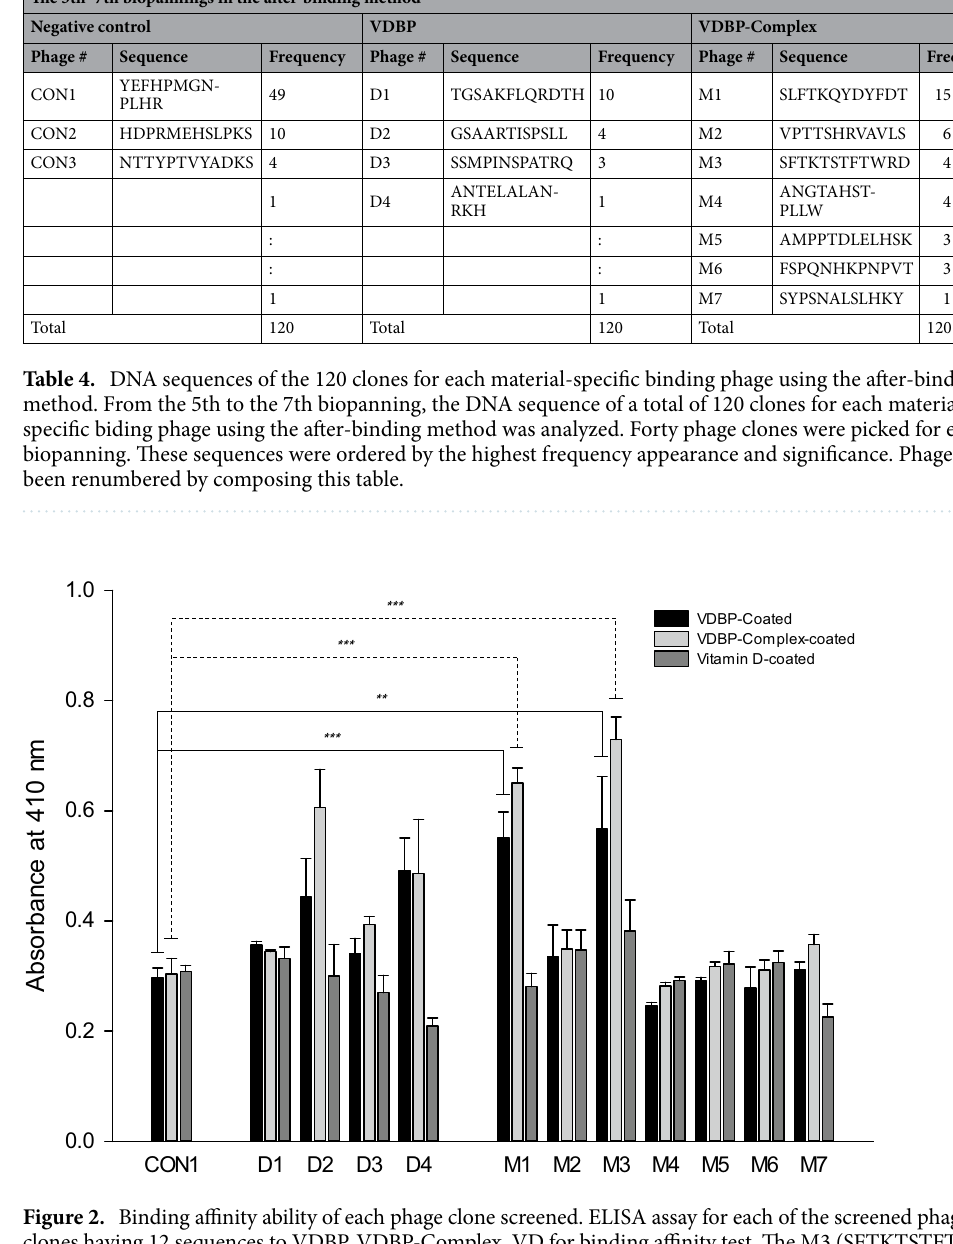
Figure 2. Binding affinity ability of each phage clone screened. ELISA assay for each of the screened phage clones having 12 sequences to VDBP, VDBP-Complex, VD for binding affinity test. The M3 (SFTKTSTFTWRD) sequence shows the highest affinity, while the M1 (SLFTKQYDYFDT) sequence shows the second highest affinity in this result. Data are expressed as the means of the absorbance value at (410 ± SD) nm (n = 3). **p < 0.01 and ***p < 0.001 vs.